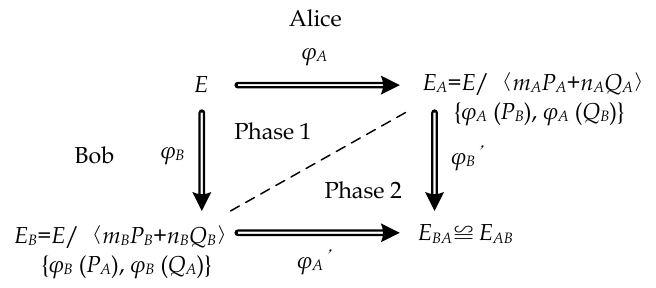
Figure 2. High-level SIDH